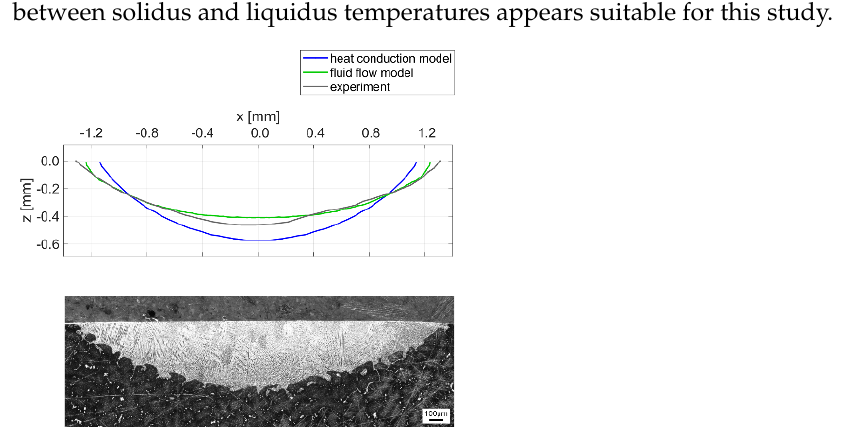
Figure 15. Single track geometries for ( a ) laser remelting only ( P = 1000 W, v = 250 mm/min), ( b ) DMD only ( P = 1000 W, m = 4.0 g/min), ( c ) laser remelting and DMD.